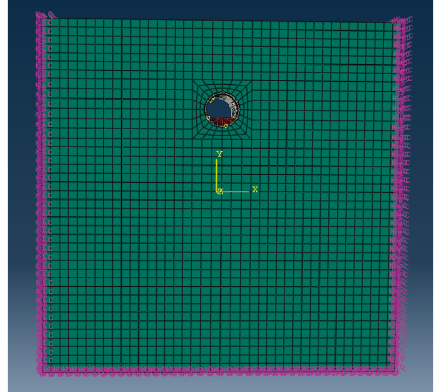
Figure 12: The finite model of the metro